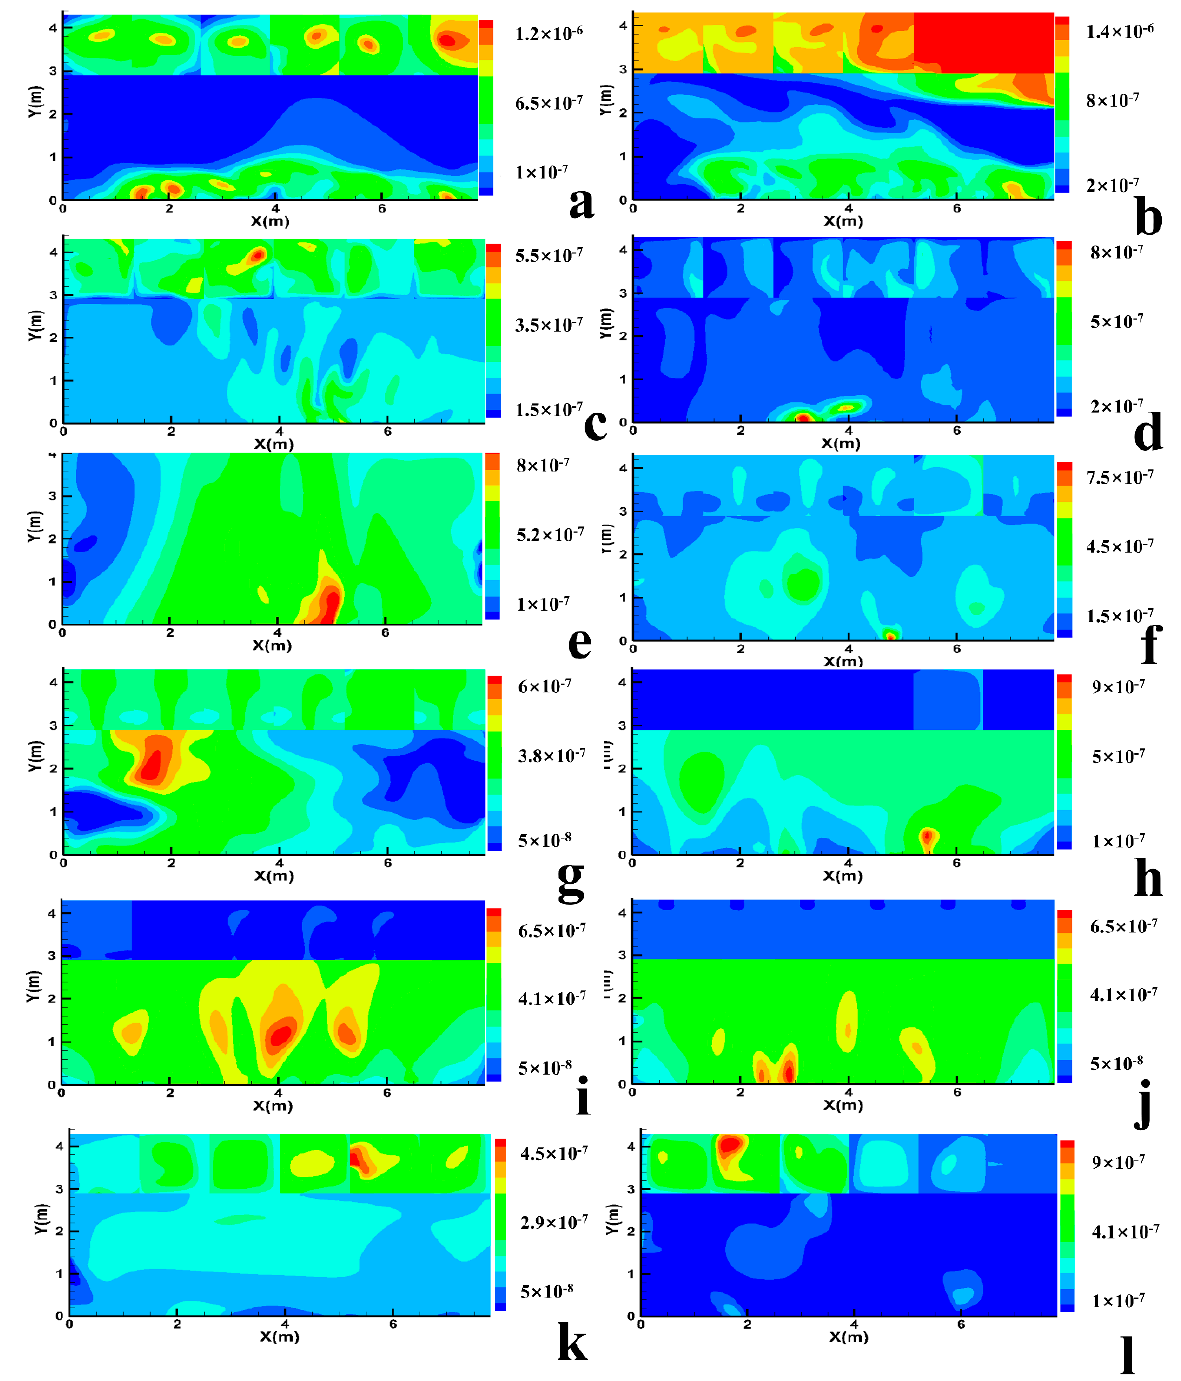
Figure 5. Ammonia concentration distribution for different cases (Z = 1.5 m, ACH = 15): ( a – l ) MV-1–IJV-7.